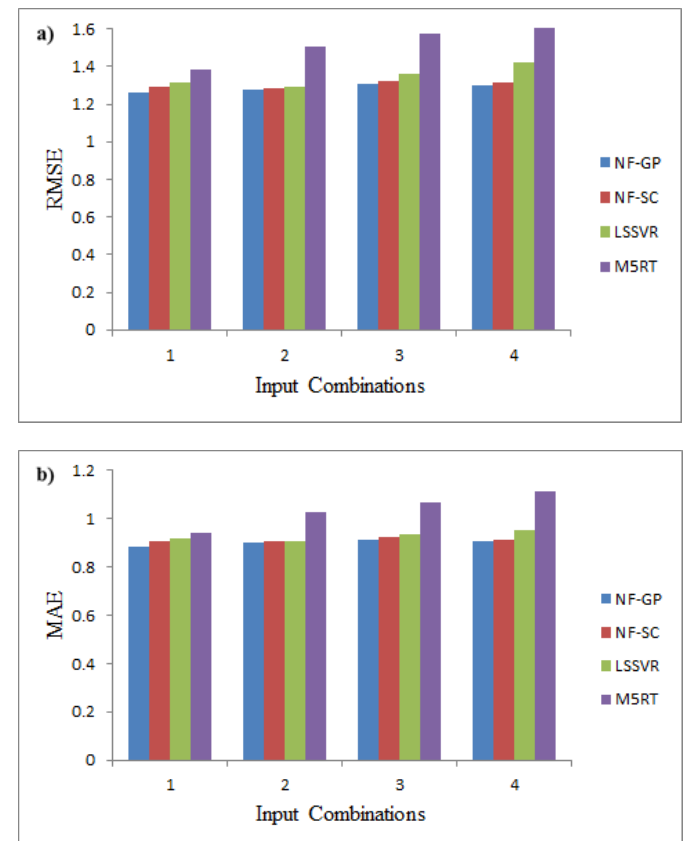
Figure 7. Average ( a ) RMSE and ( b ) MAE of the applied models in predicting wind power using all models for all input combinations.